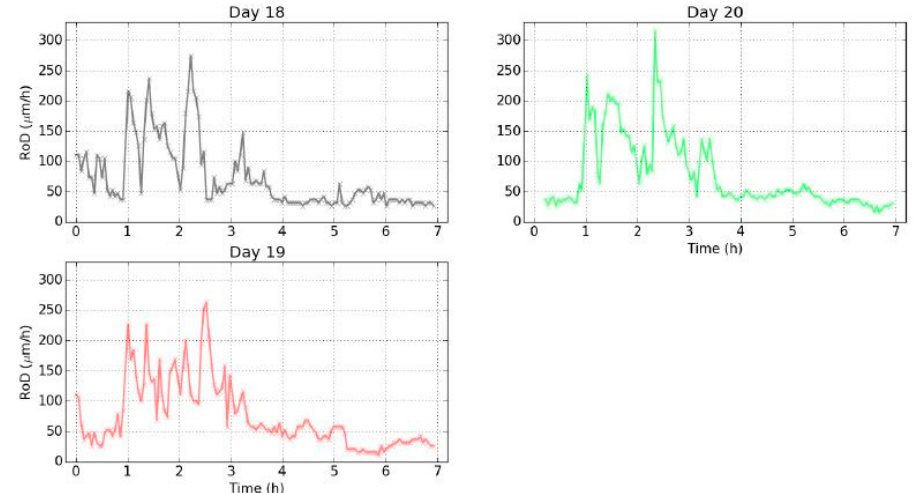
Figure 15 . Evolution of RoD from the 2nd to 19th day of experiment . Figure 15. Evolution of RoD from the 2nd to 19th day of